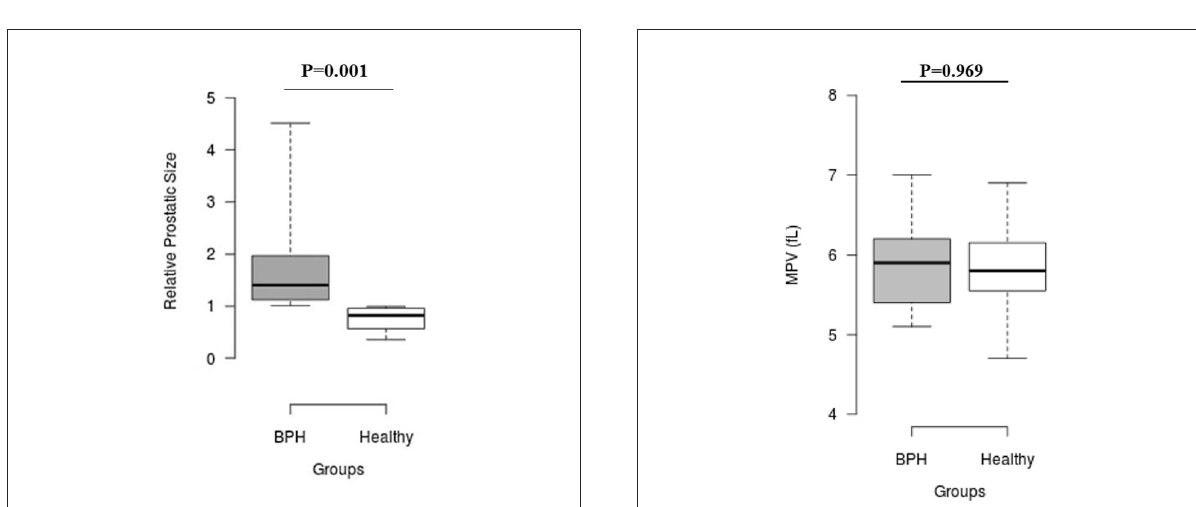
FIGURE2 Box plots of relative prostatic size ( S rel ) in BPH and Healthy groups. Center lines show the medians; box limits indicate the 25th and 75th percentiles. n = 24, 11 sample points.